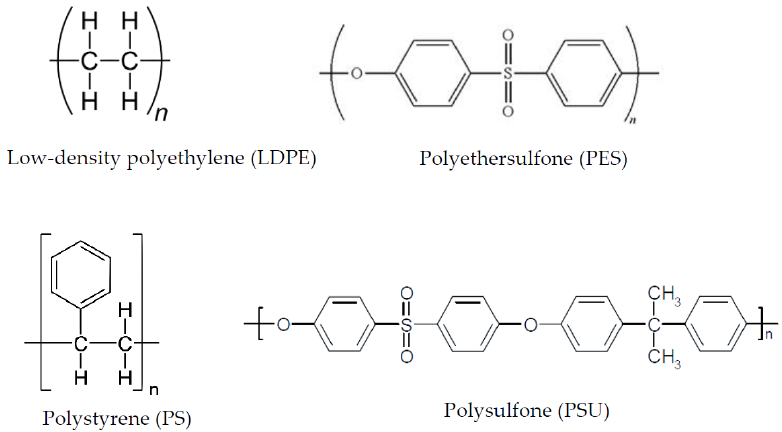
Figure 1. Molecular structure of polymers used in this paper.